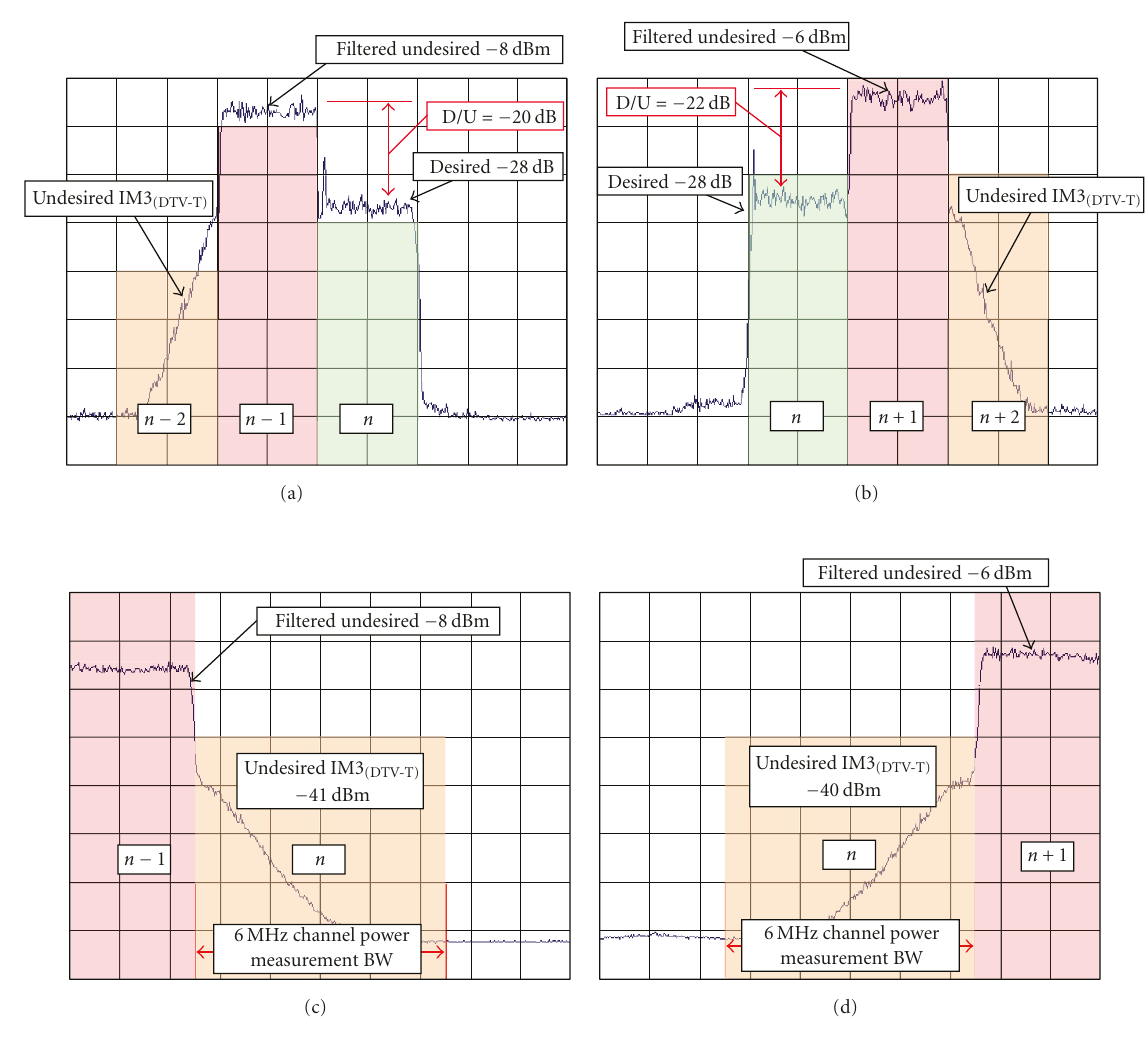
Figure 11: (a) n = − 28dBm; Undesired signal at n − 1; significant IM 3(DTV) configuration (b) n = − 28dBm; undesired signal at n + 1; significant IM 3(DTV) configuration (c) IM 3(DTV) level present in desired channel n . Undesired signal at n − 1; significant IM 3(DTV) configuration. (d) IM 3(DTV) level present in desired channel n . Undesired signal at n + 1; significant IM 3(DTV) configuration.